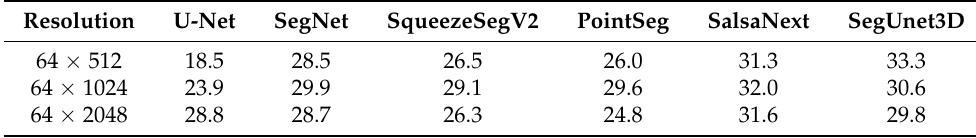
Table 2. Results of different network input size on RELLIS-3D. The values are in %. Resolution